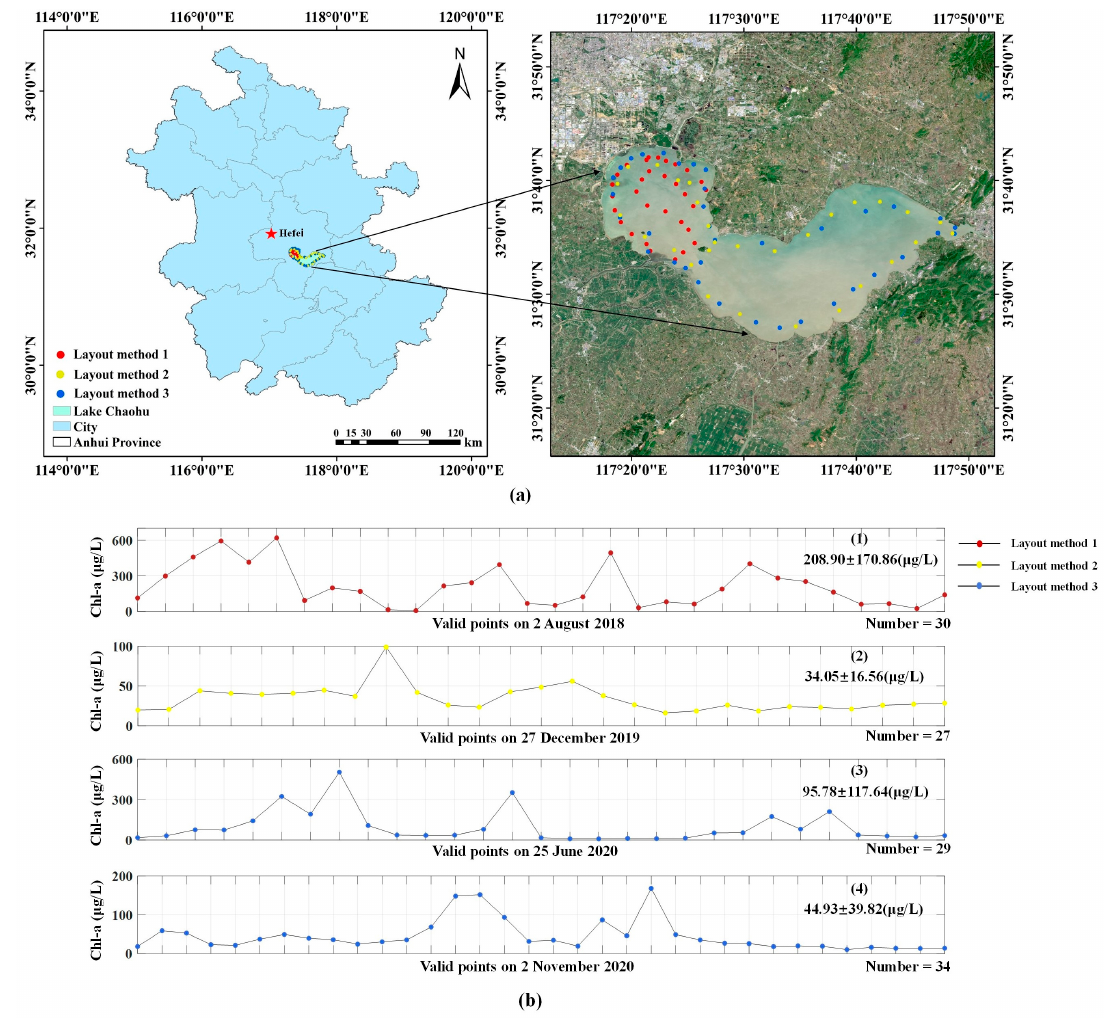
Figure 1. Study area and field survey stations. ( a ) Red, yellow, and blue dots represent the different layout methods. ( b ) In situ Chl-a at four sampling dates, with the average value ± standard deviation for each date. X-axis represents the valid sampling points (the points excluding cloud cover and measurement errors) and their number for each date.